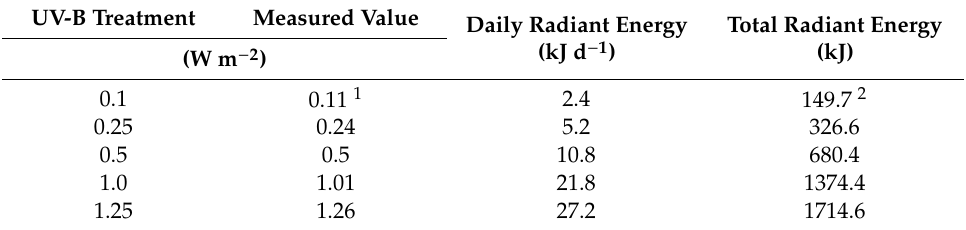
Table 2. Radiation levels and daily radiant energies of UV-B lamps for di ff erent energy treatments. UV-B Treatment Measured Value Daily Radiant Energy